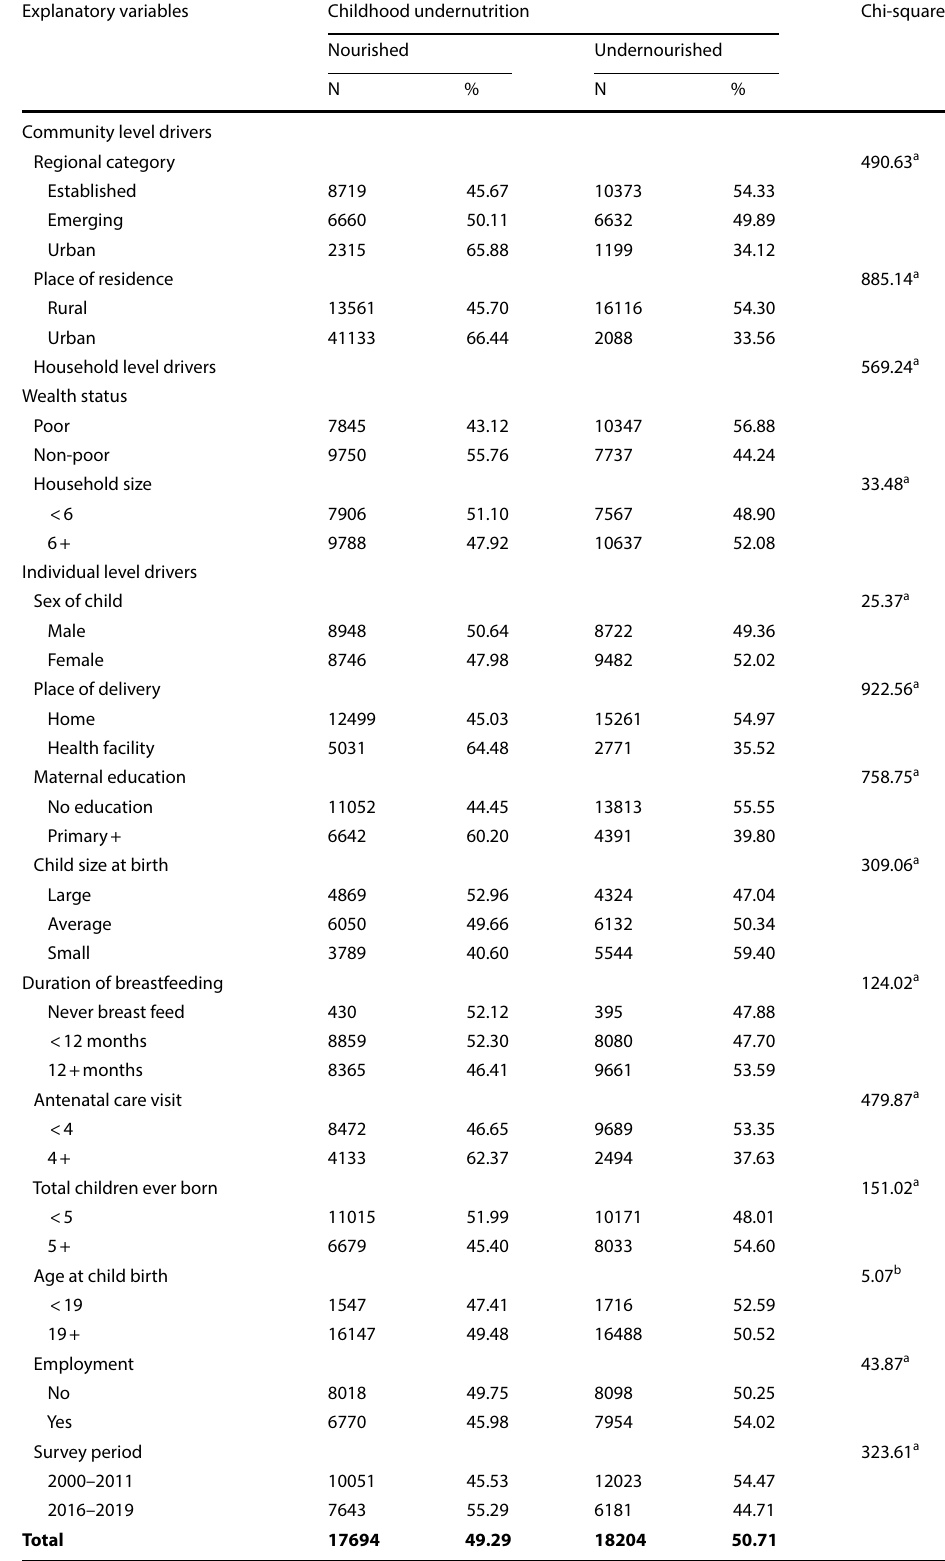
Table 2 Bivariate analysis of explanatory variables by childhood undernutrition (N = 35,898), Ethiopia,